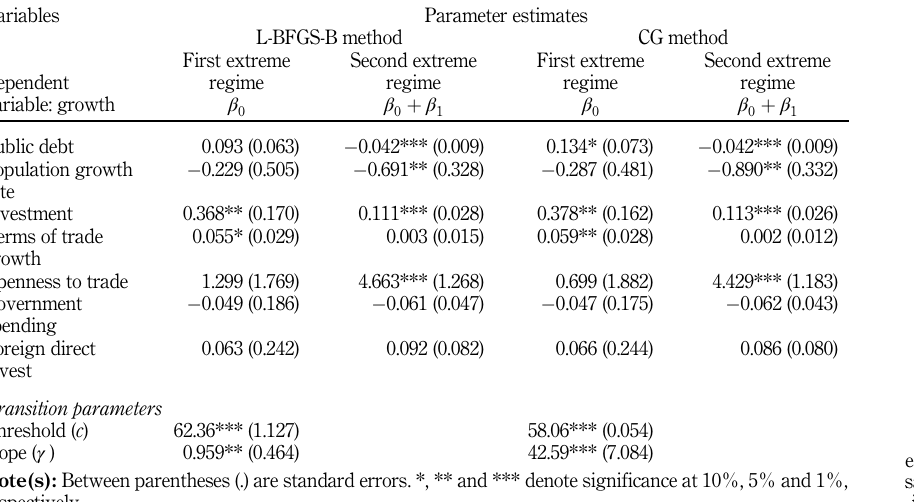
Table 7. PSTR model estimation for the sample of